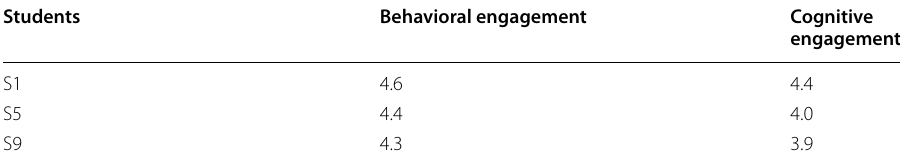
Table 5 The behavioral and cognitive engagement of the selected students Students